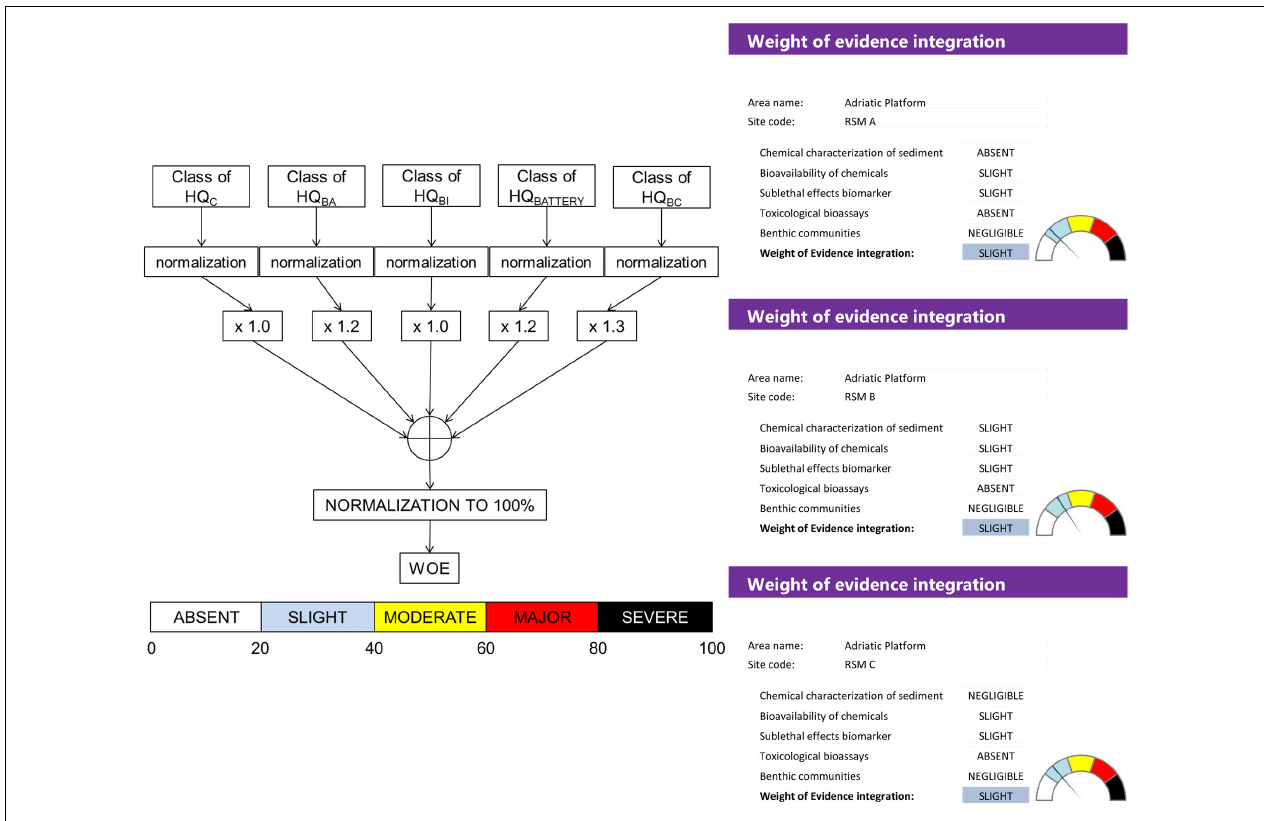
FIGURE 7 | WOE integration with normalization procedure and model output for the three